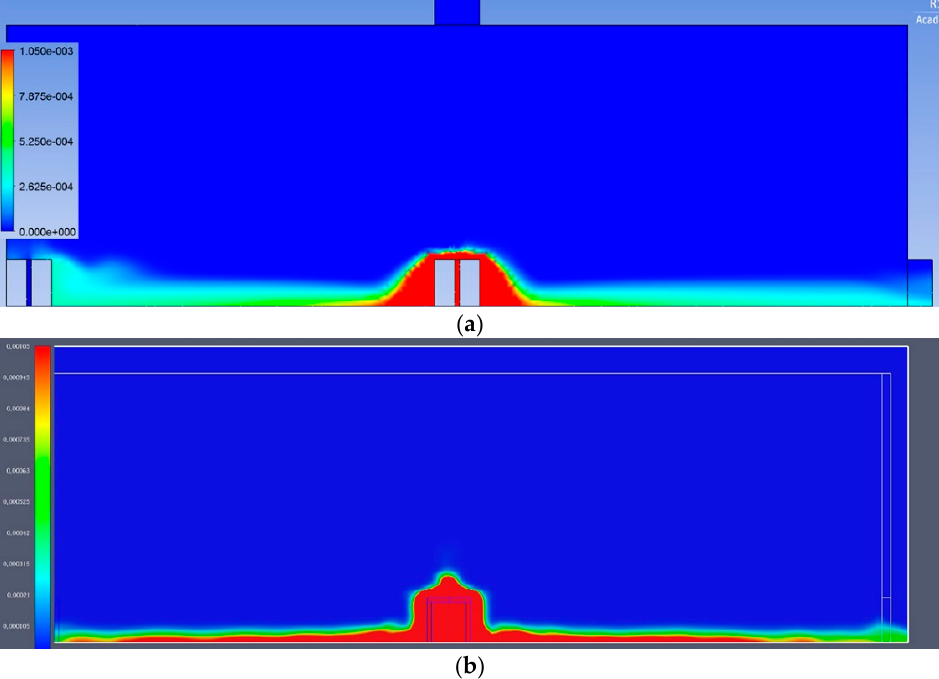
( b ) Figure 12. Iso-surface for hydrogen representing 25% concentration of LEL for ( a ) Ansys software and ( b ) FDS.